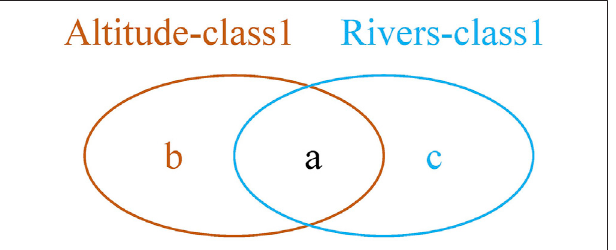
FIGURE 2 | Reclassi fi cation of altitude-class-1 and